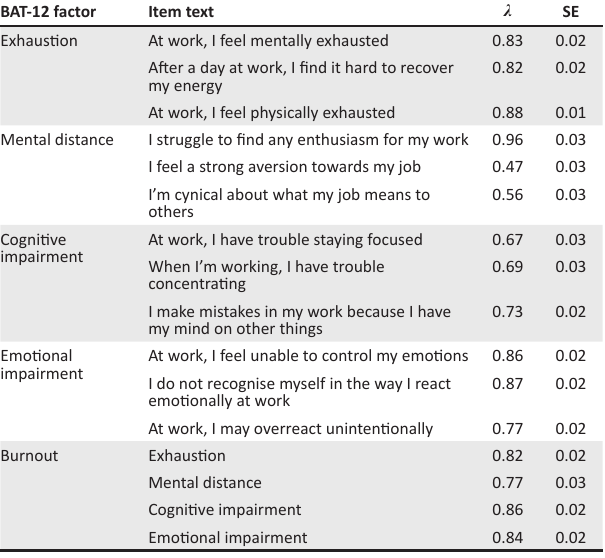
TABLE 1: Factor loadings from the confirmatory factor analysis model. BAT-12 factor